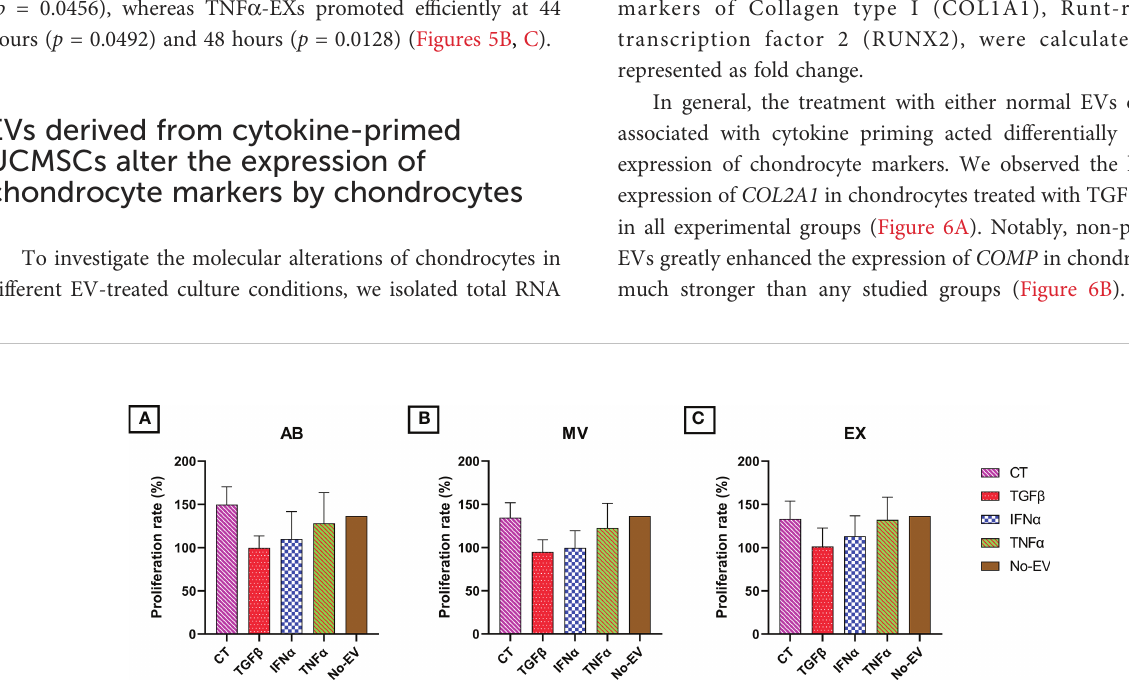
FIGURE 4 The in fl uence of EV treatment on chondrocyte proliferation at 48h. Chondrocyte proliferation under the treatment of (A) AB populations; (B) MV populations; (C) EX populations. No statistically signi fi cant effect was observed among all EV treatment groups. CT-AB/MV/EX: chondrocytes treated with AB/MV/EX secreted from non-priming UCMSCs; TGF b -AB/MV/EX: chondrocytes treated with AB/MV/EX secreted from TGF b - primed UCMSCs; IFN a -AB/MV/EX: chondrocytes treated with AB/MV/EX secreted from IFN a -primed UCMSCs; TNF a -AB/MV/EX: chondrocytes treated with AB/MV/EX secreted from TNF a -primed UCMSCs; No-EV: chondrocytes cultured in DMEM/F12 5% EV-depleted FBS and no EV addition. The proliferation rate was acquired by normalizing absorbance measured at time point of 48 hours after incubation to absorbance measured at seeding time (0h), and the data were obtained from three independent biological replicates (n = 3). Statistical signi fi cance was determined by Two-Way ANOVA. Error bars indicate ± SD.